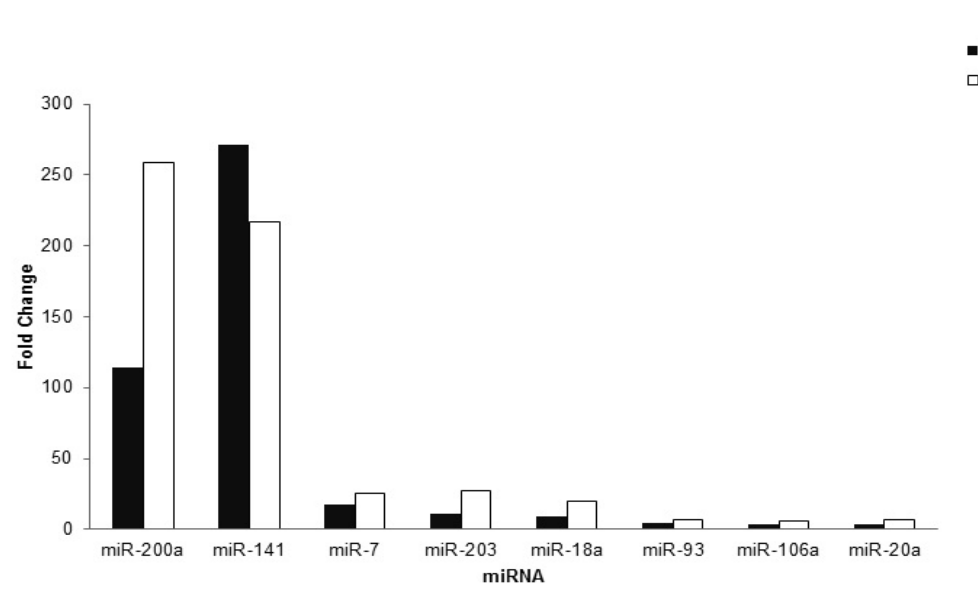
Figure 2. Validation of eight upregulated miRNAs found in the profiling study. The validation data shows good concordance with the profiling data ( p < 0.05), thus confirming the profiling results.